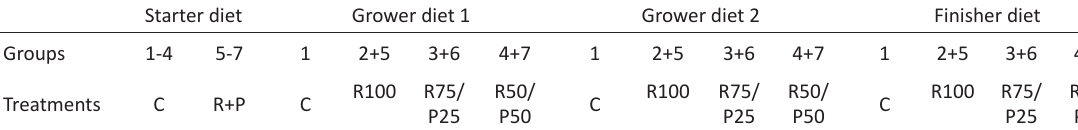
Table 2. Calculated and analysed chemical composition (g kg -1 DM, except DM and AME) of experimental diets Starter diet Grower diet 1 Grower diet 2 Finisher